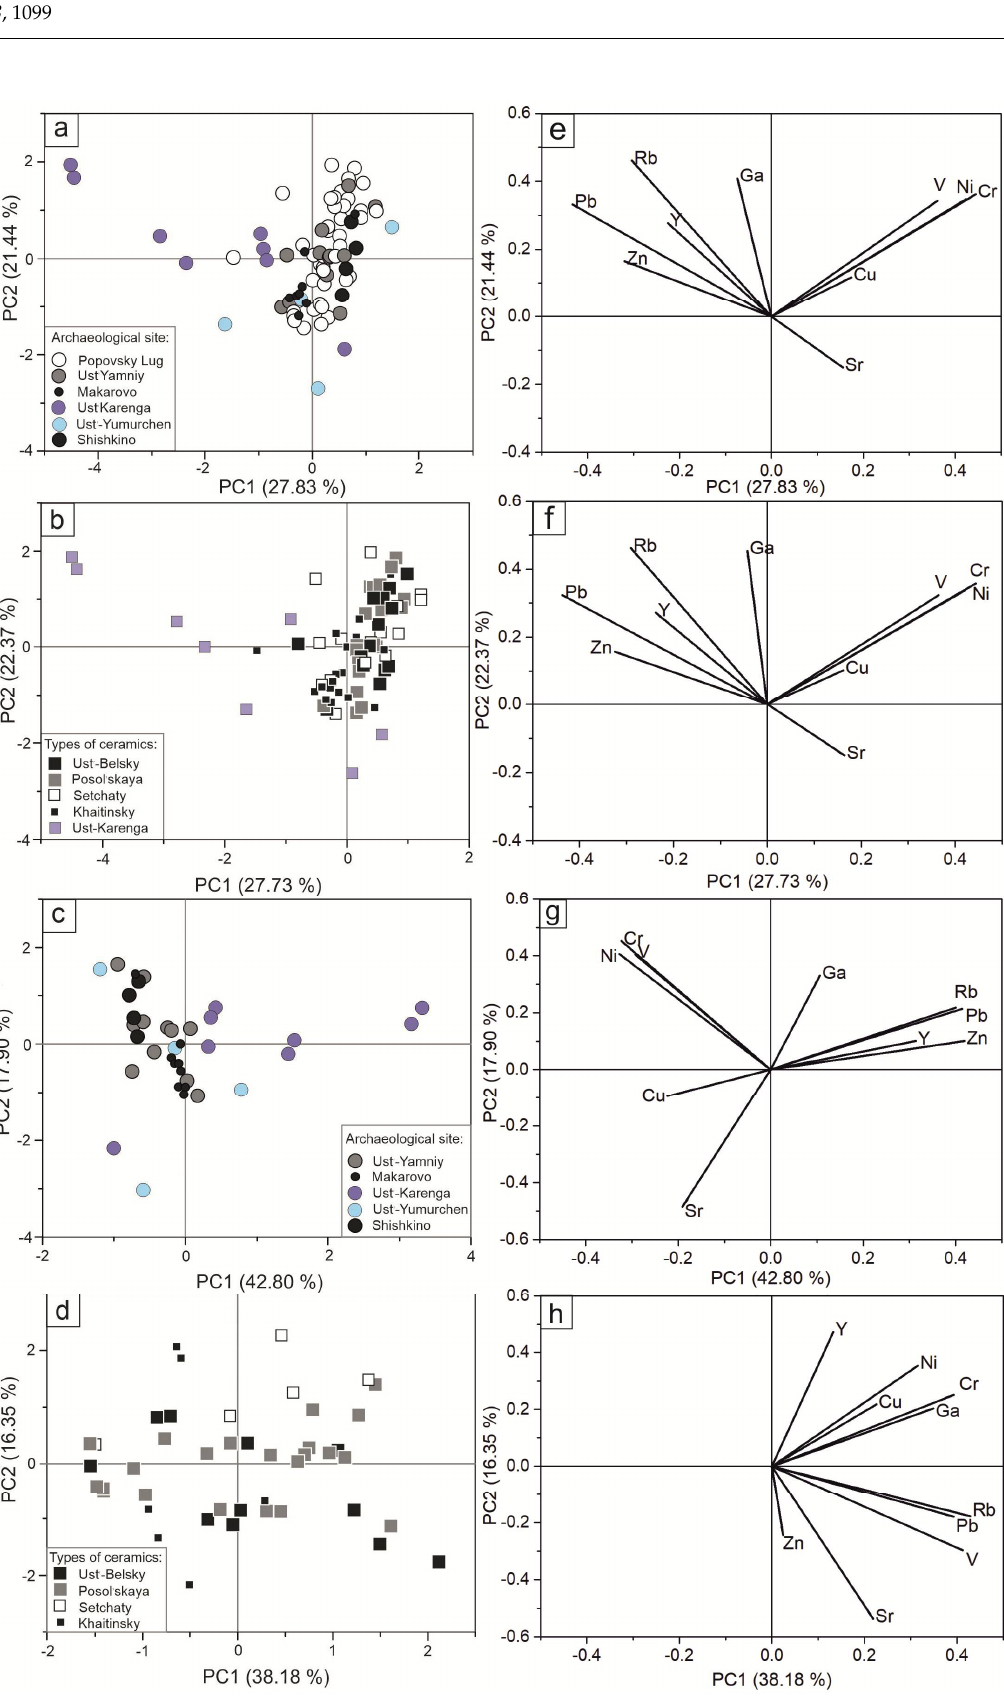
Figure 3. PCA score (a-d) and loading (e-h) plots calculated for elemental composition of ceramic samples performed with division by archaeological site ( a, e —all samples; c, g —samples without Popovsky Lug) and type ( b, f —all types; d, h —samples from Popovsky Lug).